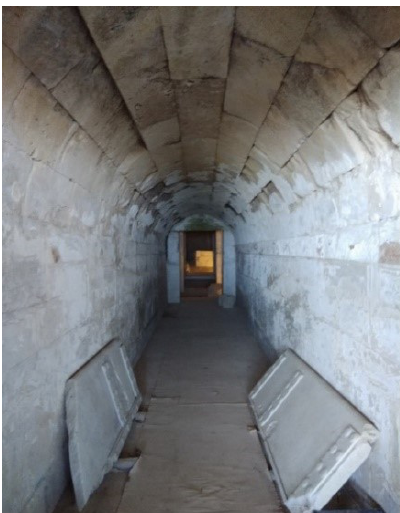
Figure 3: The Macedonian tomb of Heuzey